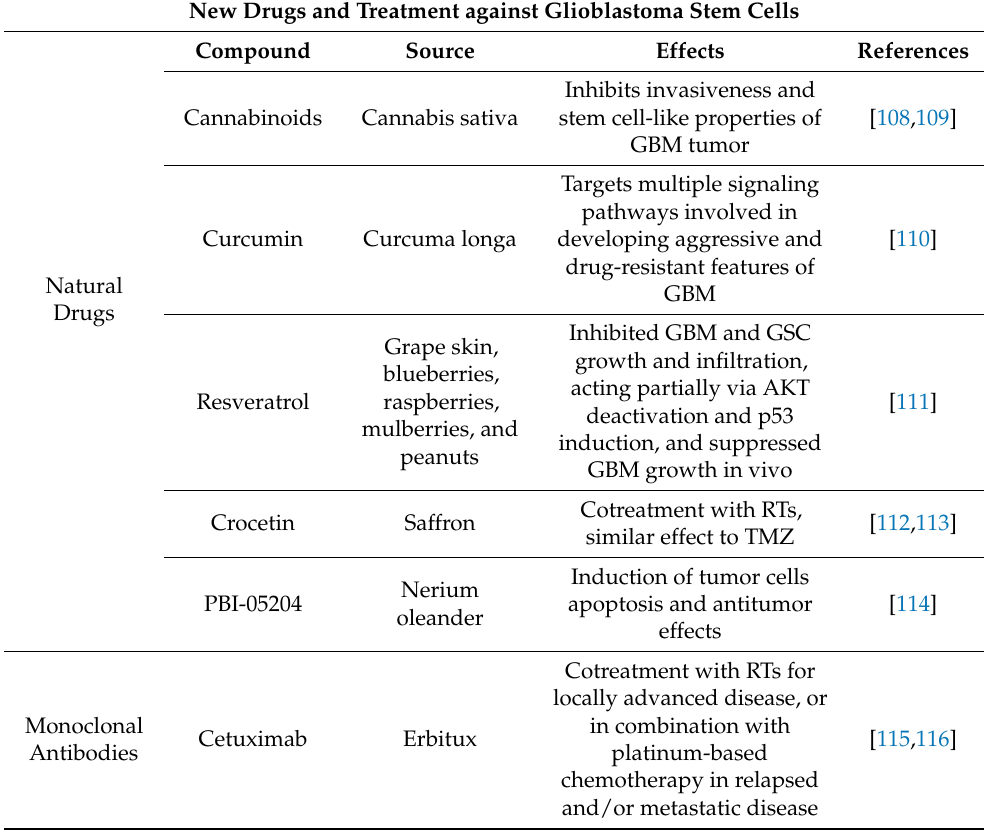
Table 2. Potential new drugs and treatment against glioblastoma stem